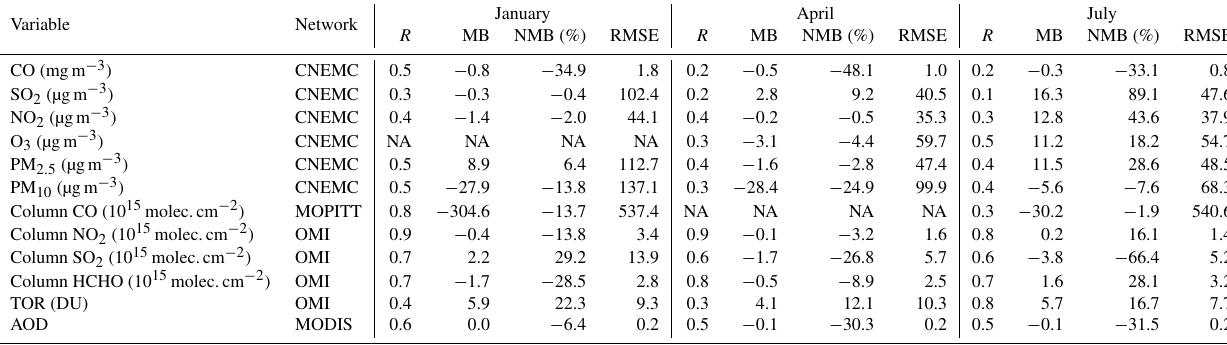
Table 4. Model performance statistics for the air quality application: chemical variables (2013, NCEP_BASE). Variable